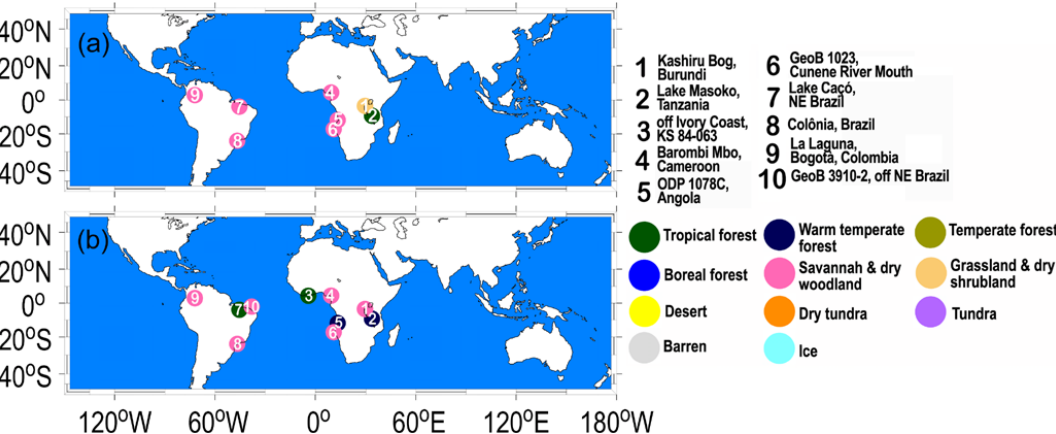
Fig. 4. Sites of pollen records compiled by Hessler et al. (2010) for the LGM (a) and HE1 (b) . Biome reconstructions at each site are represented by the colors of the circles (see legend).